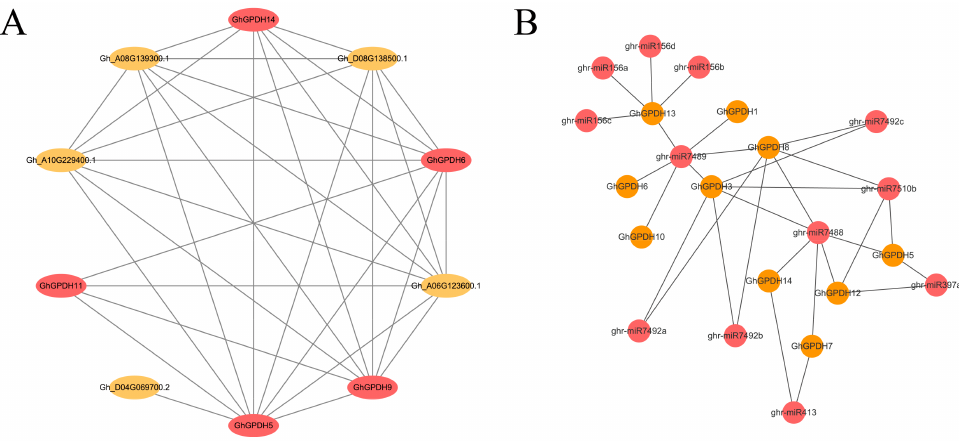
Figure 8. Network diagram of GPDH5 protein interactions and miRNAs targeting the GPDH family in G. hirsutum . ( A ) Interactive relationships of GPDH5 in G. hirsutum . ( B ) Network of miRNAs associated with GPDH genes in G. hirsutum